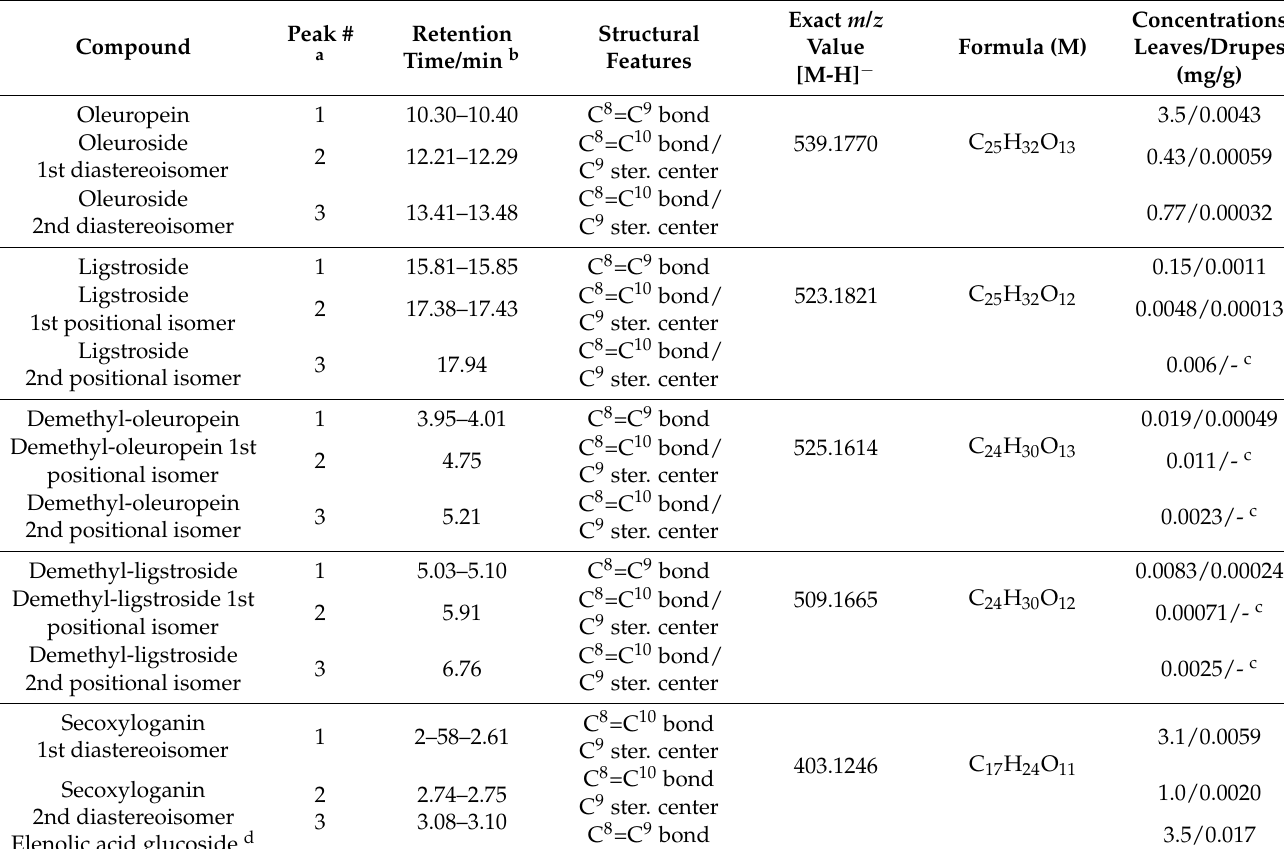
Table 1. Summary of chromatographic, structural, and mass spectrometric information on secoiridoids characterized in olive leaves and drupes during the present study. Estimates of secoiridoids concentrations in olive leaves and drupes (mg/g), expressed as oleuropein equivalents and shown in the last column were obtained as average values from three replicates; the maximum relative standard deviation on reported data is